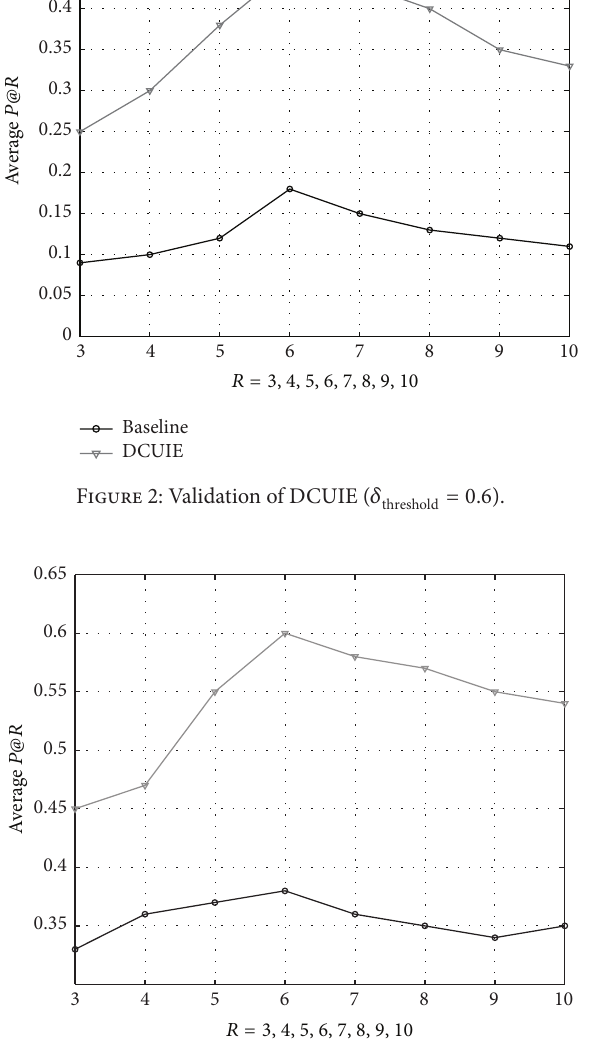
Figure 3: Comparison of experimental result between MCUIE and